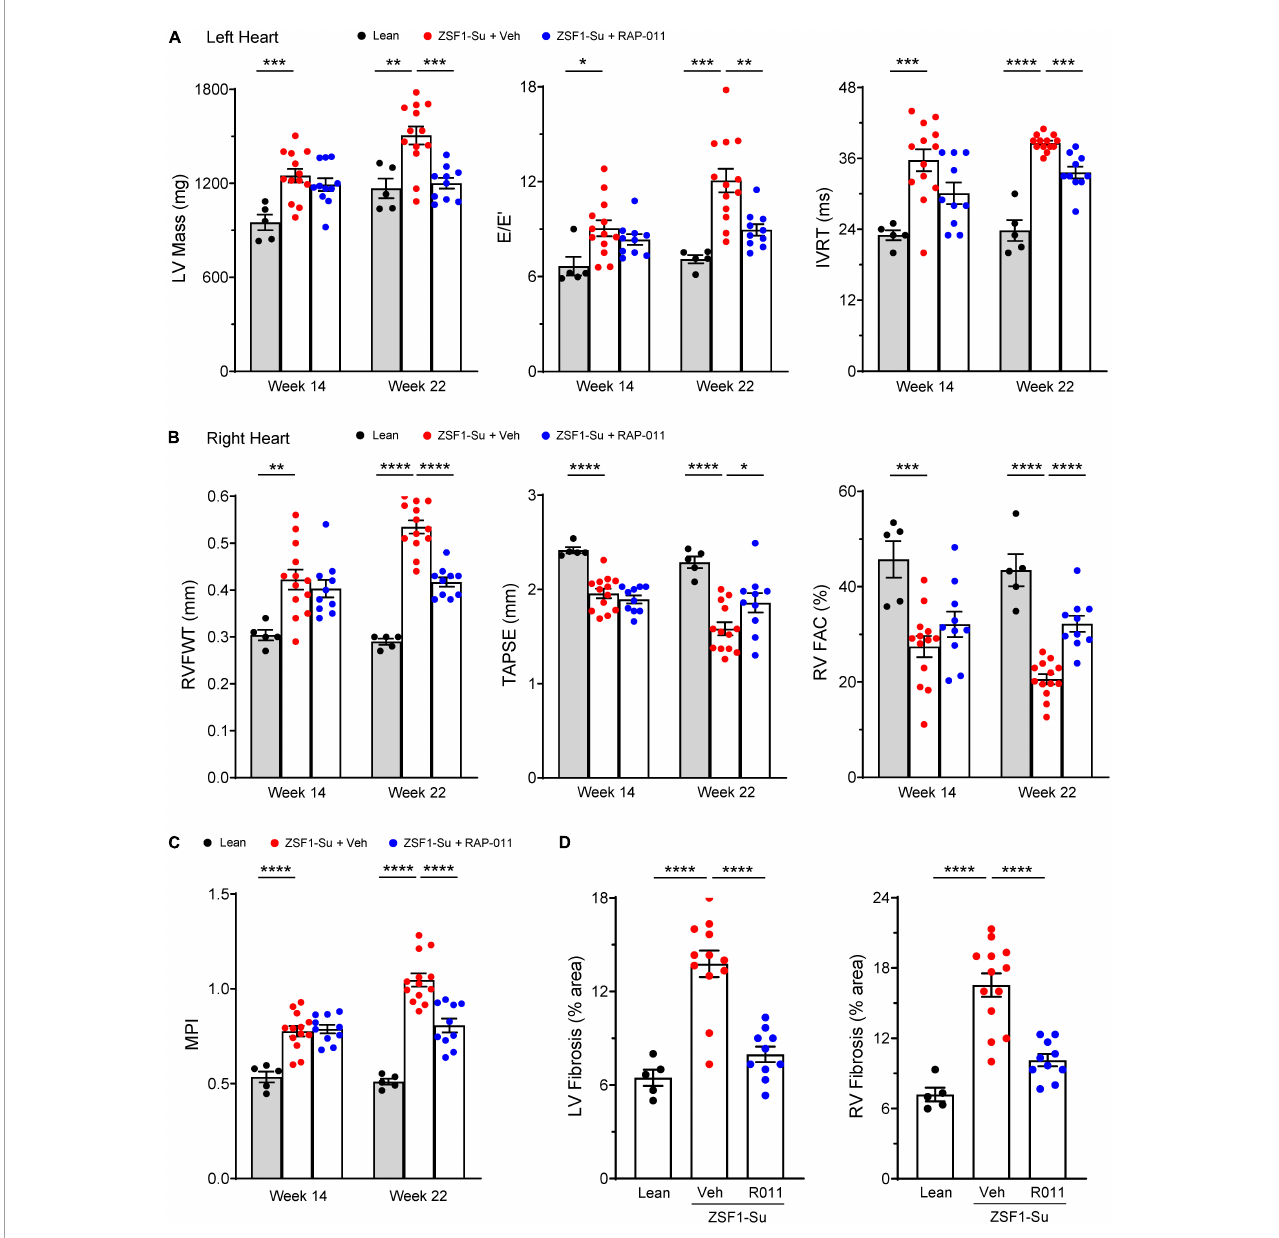
FIGURE5 ActRIIA-Fc improves remodeling and function of both left and right heart in obese ZSF1-Su rats. Effects of ActRIIA-Fc (RAP-011, R011) on (A) left heart parameters LV mass, mitral inflow velocity (E) and mitral annular velocity (E’) ratio (E/E’), and isovolumic relaxation time (IVRT); (B) right heart parameters RV free-wall thickness (RVFWT), tricuspid annular plane systolic excursion (TAPSE), and RV fractional area change (RVFAC); (C) myocardial performance index (MPI); and (D) quantification of fibrosis in LV and RV. Data are means ± SEM ( n = 5–13 rats per group). Analysis by one-way ANOVA and Dunnett’s post-hoc test. * P < 0.05; ** P < 0.01; *** P < 0.001; **** P <